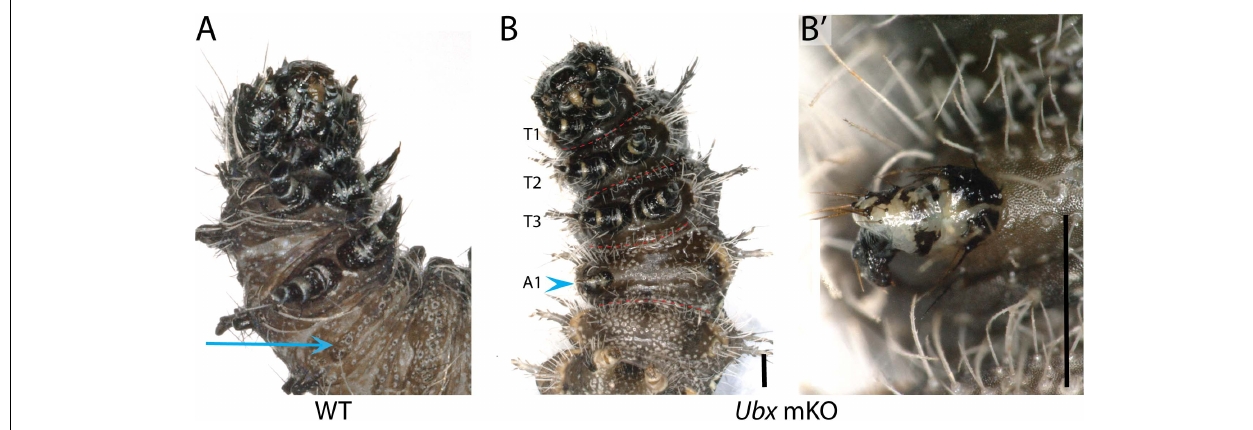
FIGURE 5 | Loss of Ubx produces ectopic abdominal legs. (A) WT fifth instar larva, ventral view; arrow: A1 ventral epithelium. (B,B’) Partial limb (arrowhead, magnified in B’ ) on the A1 segment of a fifth instar Vanessa cardui Ubx mKO larva. Scale bars = 1000 µ